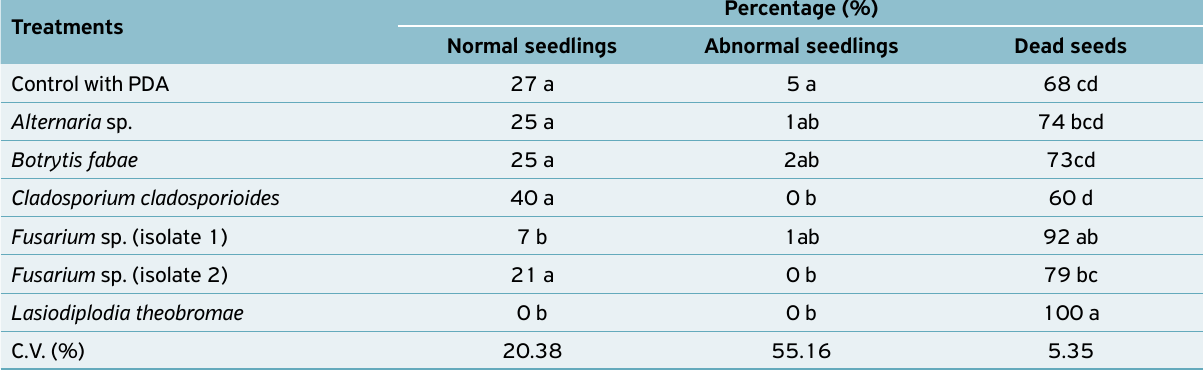
Lasiodiplodia theobromae 0 b 0 b 100 a C.V. (%) Means transformed into (x + 0.5) ^ 0,5. Means followed by the same lowercase letter in the column do not differ from each other by the Tukey test (p ≤